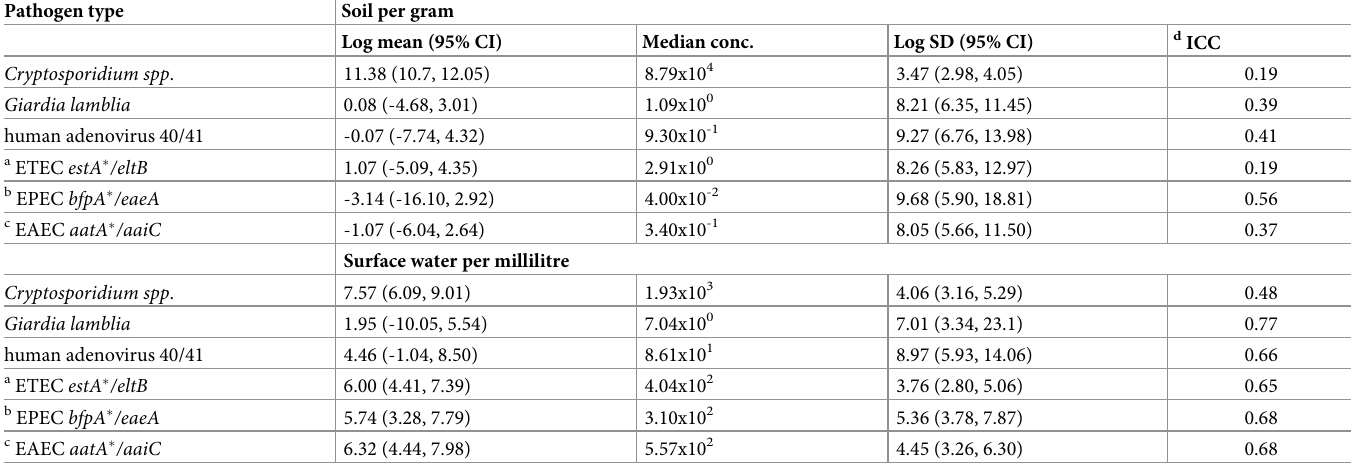
Table 2. Tobit model-simulated log mean (95% credible intervals), median concentrations (conc.), total log standard deviation (SD) (95% credible intervals), and interclass correlation coefficient (ICC) of enteric viruses, bacteria, and protozoans detected per gram (g) of soil and milliliter (mL) of surface water public areas of Kisumu where children